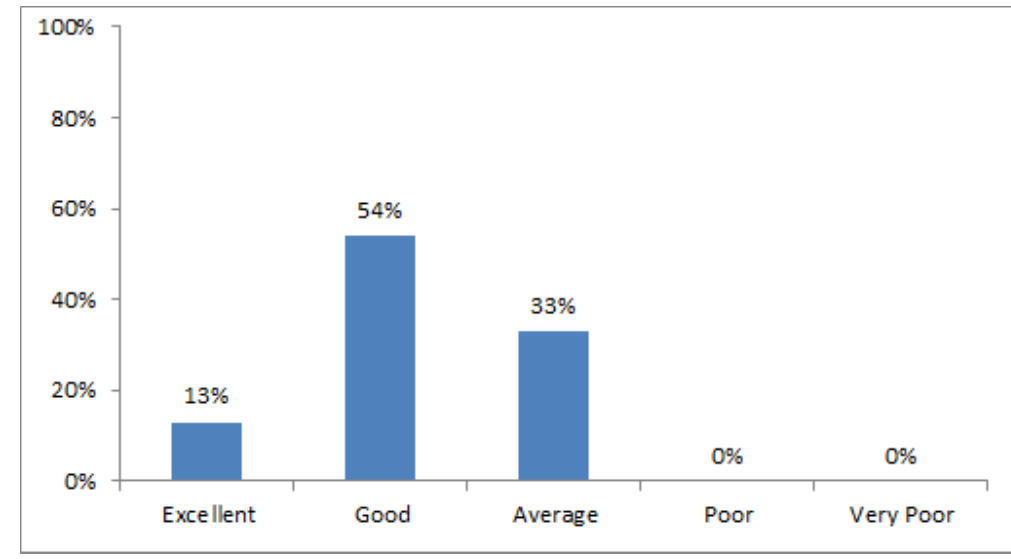
Figure 9. Evaluation of the relationship between the business and ICT